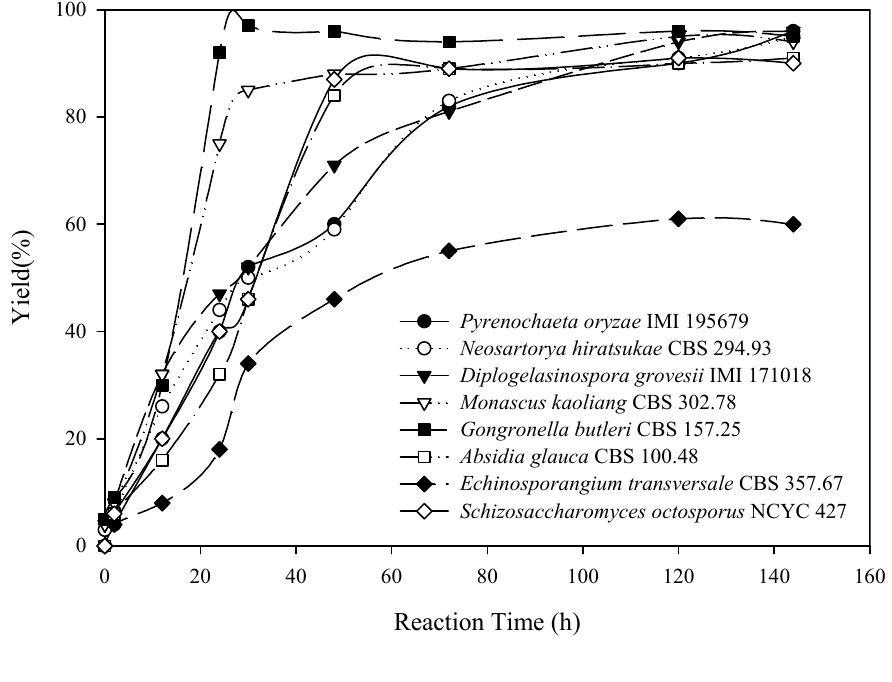
Figure 2. Kinetic profiles of the reduction of cyclohexanone (Figure A) and of the oxidation of cyclohexanol (Figure B) using the selected microorganisms